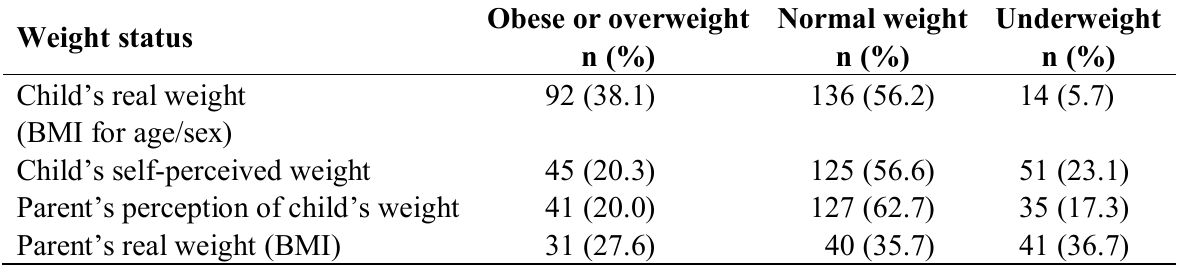
Table 1. Estimates of Real and Perceived Weight Status among Elementary School Students and their Parents, Cayey, Puerto Rico,